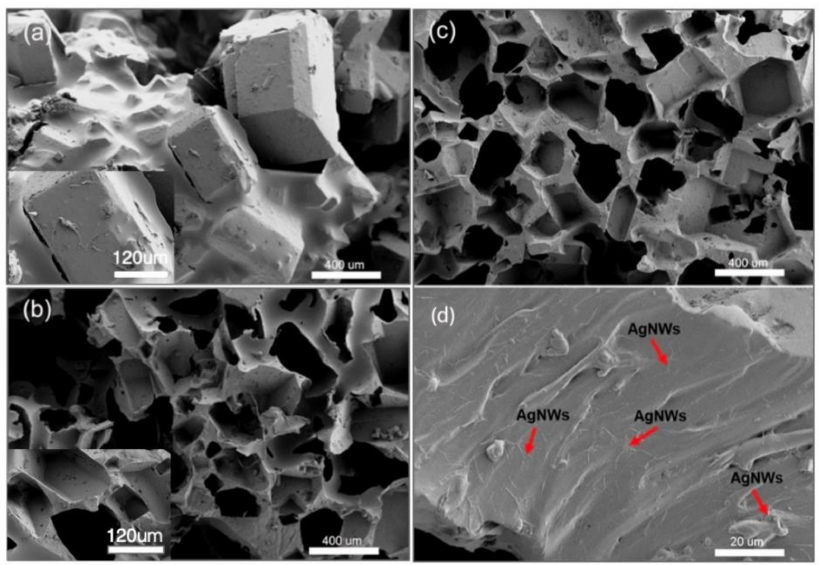
Figure 4. ( a ) SEM images of PDMS + sucrose. ( b ) SEM images of PDMS sponges. ( c ) SEM images of PAP sponges. ( d ) Final structure of porous PAP sponges. Insets are the high magnification SEM